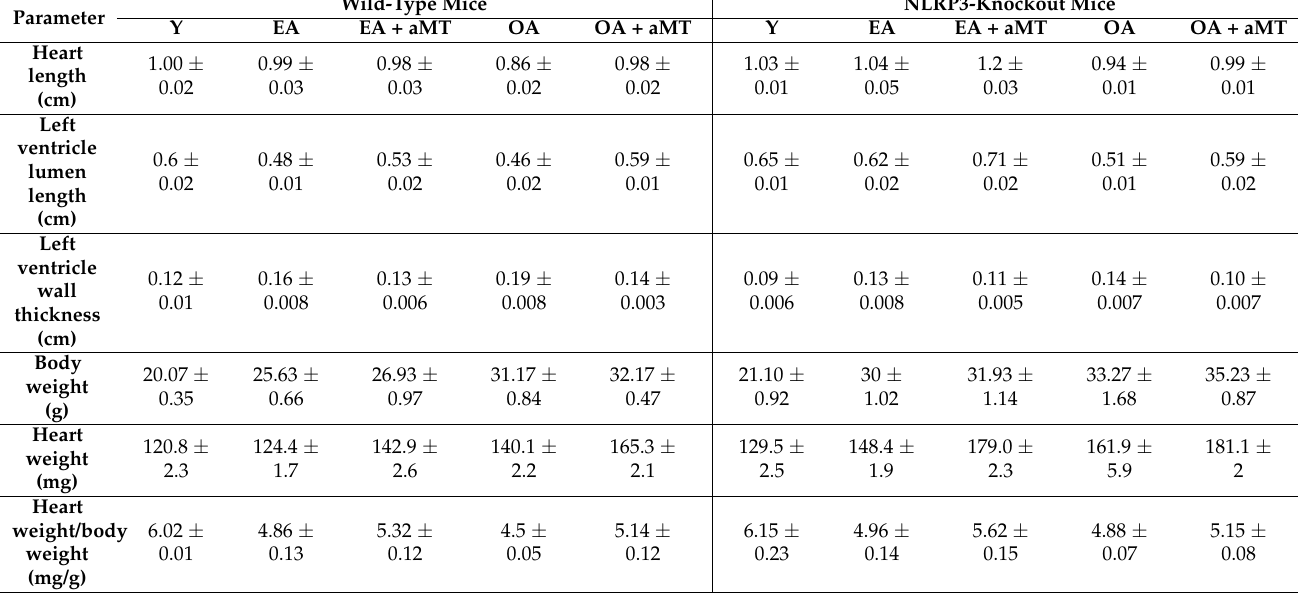
Table 1. Morphometrical analyses of MRI and anthropometric parameters during